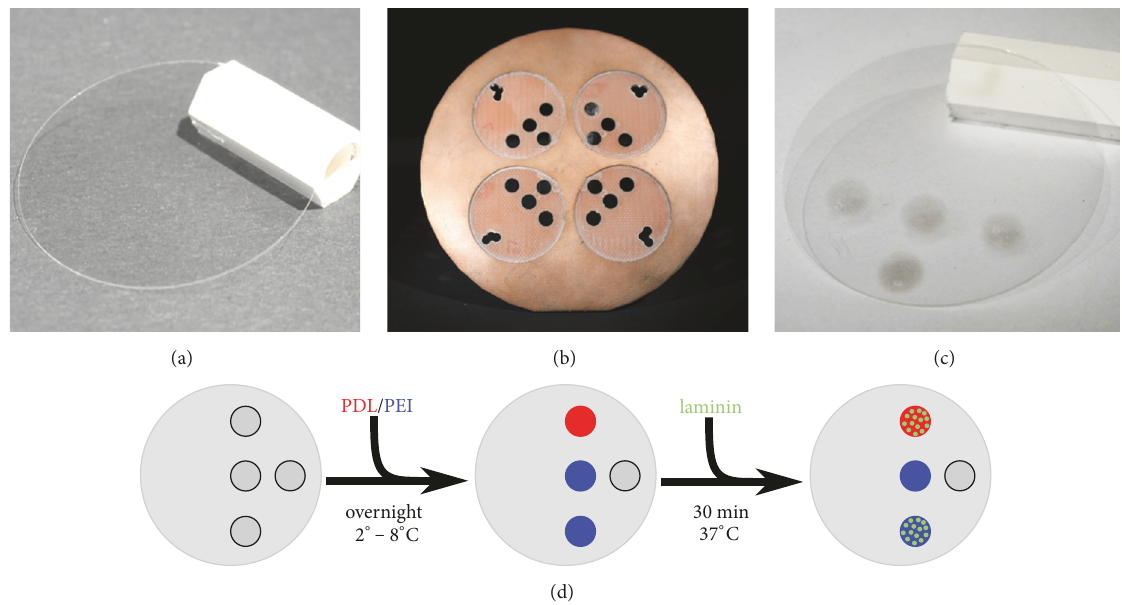
Figure 1: A32-mmglasscoverslipprior tosilicon nitride coating(a); homemadesputtermask(b),and coatedglasscoverslipwith foursilicon nitride spots (c). (d) presents a schematic presentation of the coating procedure of the silicon nitride spots with PDL, PEI, and laminin. The fresh silicon nitride spots were incubated overnight with droplets of PEI (red) or PDL (blue) (left and center). Prior to the experiments, two spots were incubated with laminin (green) for 30 minutes